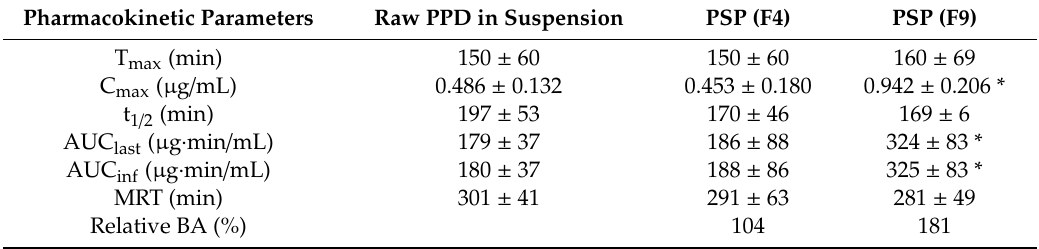
Figure 7. Plasma concentration–time profiles of PPD in Sprague Dawley rats after oral administration of raw PPD, F4 and F9 at a dose of 10 mg / kg ( n = 4). Table 3. Pharmacokinetic parameters of PPD in male rats after oral administration of an equivalent dose (10 mg/kg) of raw PPD and F9 ( n = 4).